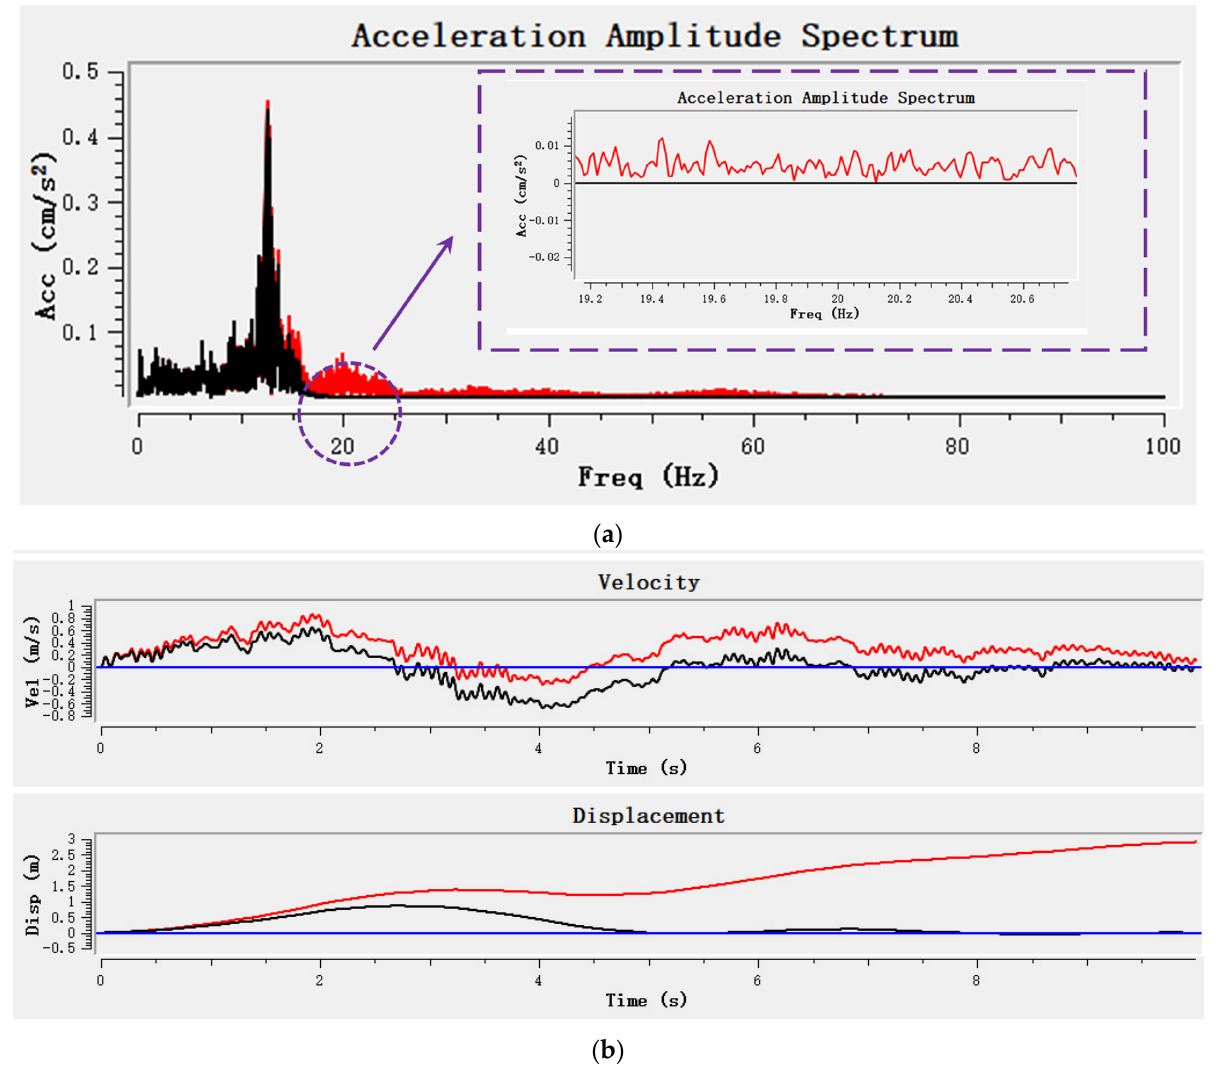
Figure 9. Seismic wave filtering and baseline correction. ( a ) Seismic wave filtering (black line: filtered waveform; red line: original waveform). ( b ) Baseline correction (black line: velocity and displacement curve after correction; red line: velocity and displacement curve before correction; blue line: reference line).